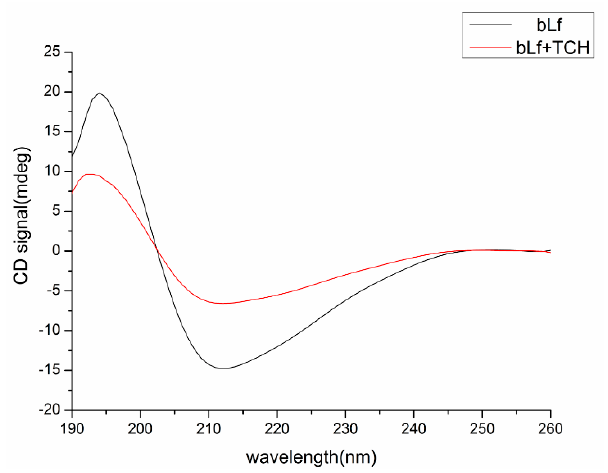
Figure 5. Far-UV CD spectra of bLf in the absence and presence of TCH at pH 6.6. c (TCH)/c (bLf) = 1:1.